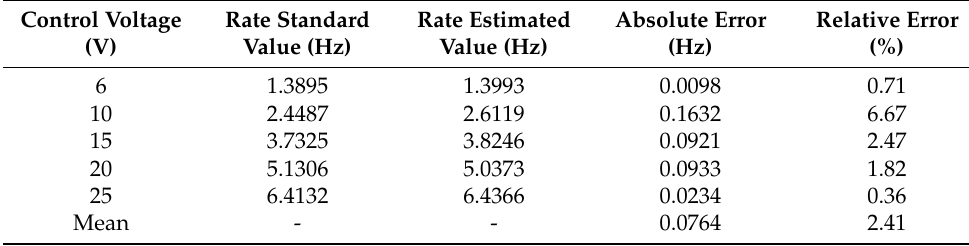
Table 4. Cube target spin rate estimation